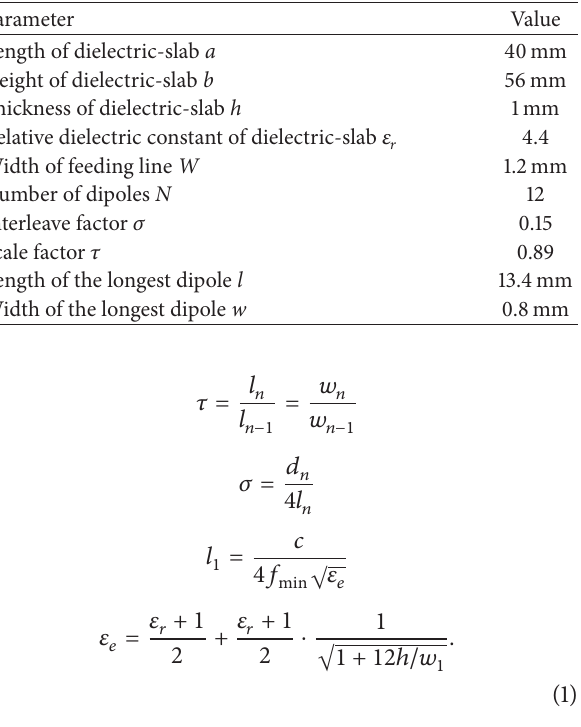
Table 1: Optimization results of antenna